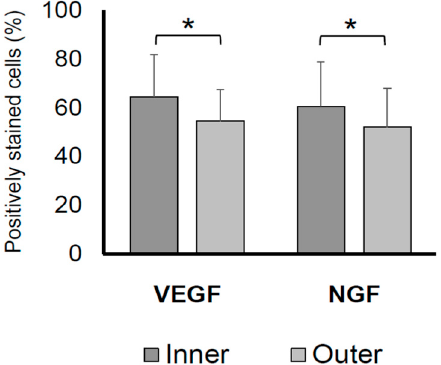
Figure 2. Percentages of VEGF- and NGF-positive cells on the inner and outer acetabular labral surfaces. The VEGF- and NGF-positive stained cell rate in the labral inner region was significantly higher than that in the labral outer region ( p < 0.05). * p < 0.05. NGF, nerve growth factor; VEGF, vascular endothelial growth factor.